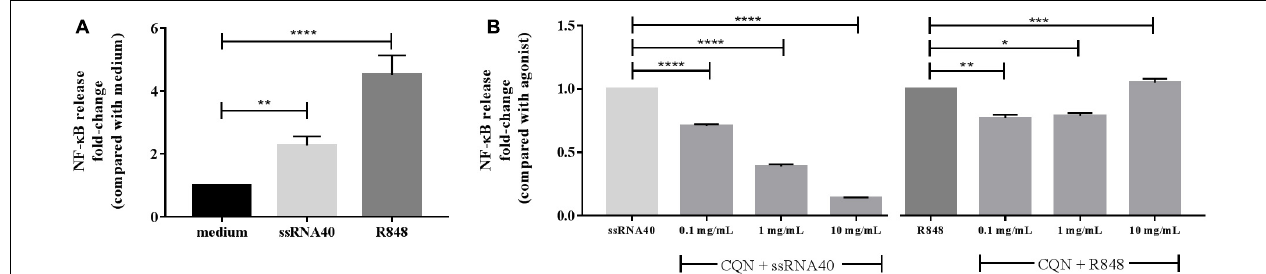
FIGURE 3 | Inhibitory effects of CQN on ssRNA 40 and R848 induced activation of TLR-8. The TLR-8 agonists ssRNA40 (50 µ g/mL) and R848 (100 µ g/mL) were used to stimulate TLR-8 expressed in HEK293 cells after pre-incubation with chloroquine (CQN) for 1 h at 0.1, 1, and 10 mg/mL ( n = 4). (A) Fold-change activation induced by CQN compared with the untreated cells/medium. (B) Fold-changes in the inhibition of ssRNA40 or R848 induced TLR-8 activation. NF- κ B release was measured by spectrophotometry at 650 nm. Data is represented as mean ± SEM. Statistical differences were measured using One-way ANOVA and post hoc Tukey’s test. Significant differences compared to ssRNA40 and R848 are indicated by * p < 0.05, ** p < 0.01, *** p < 0.001, and **** p <